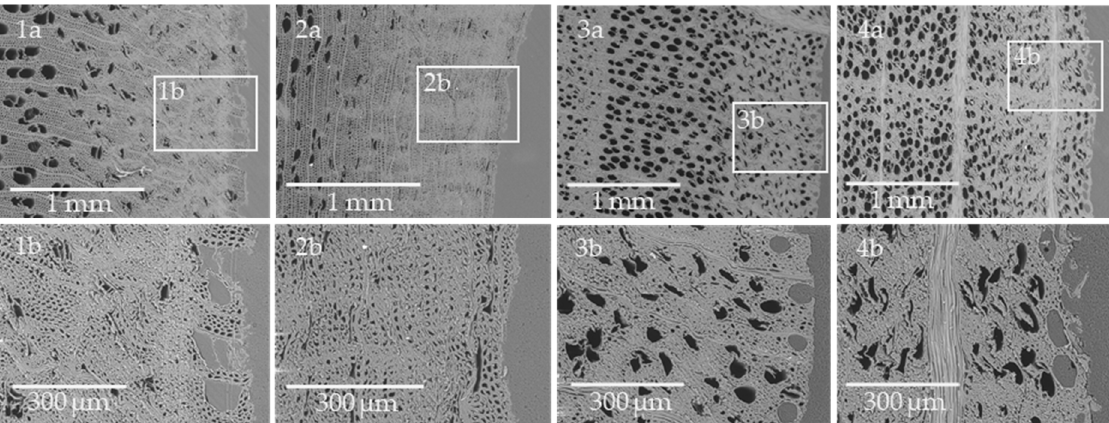
Figure 7. Representative SEM micrographs recorded on the cross-section of the overmolded specimens for birch solid wood ( 1a – 2b ) and beech solid wood ( 3a – 4b ); b represents always the detailed inset of a. ( 1a ), ( 1b ), ( 3a ) and ( 3b ) show samples overmolded in radial direction and ( 2a ), ( 2b ), ( 4a ) and ( 4b ) represents samples overmolded in tangential direction.